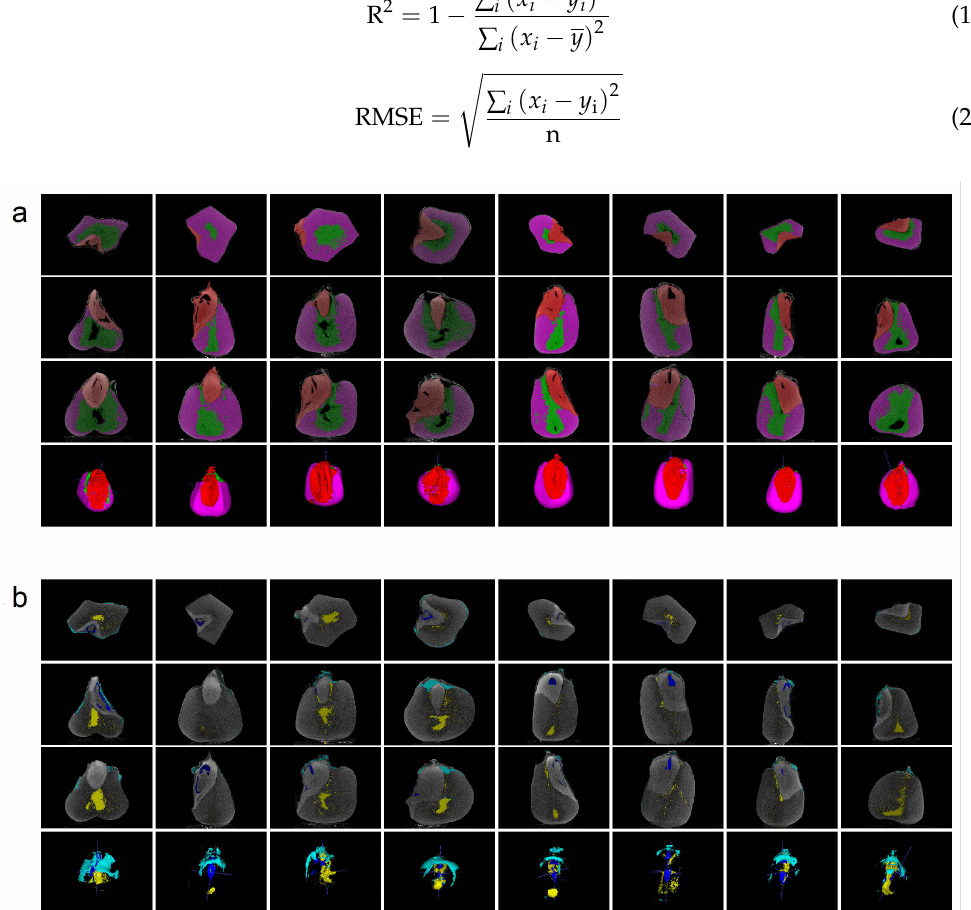
Figure 2. The visualization of the segmentation results of the embryo, endosperm, and cavity. Note: ( a ) The segmentation results of embryo and endosperm. Red, pink, and green represent embryo, horny endosperm, and silty endosperm, respectively; each column represents a kernel sample, and rows 1 to 4 represent cross-sectional, coronal, sagittal, and 3D reconstruction results, respectively. ( b ) The segmentation results of the cavity. Cyan, yellow and blue represent the subcutaneous cavity, embryonic cavity, and endosperm cavity, respectively; each column represents a kernel sample, and rows 1 to 4 represent the cross-sectional, coronal, sagittal, and 3D reconstruction results, respectively. Therein, x represents the volumes calculated using ITK-SNAP, and y represents the volumes calculated using the phenotyping